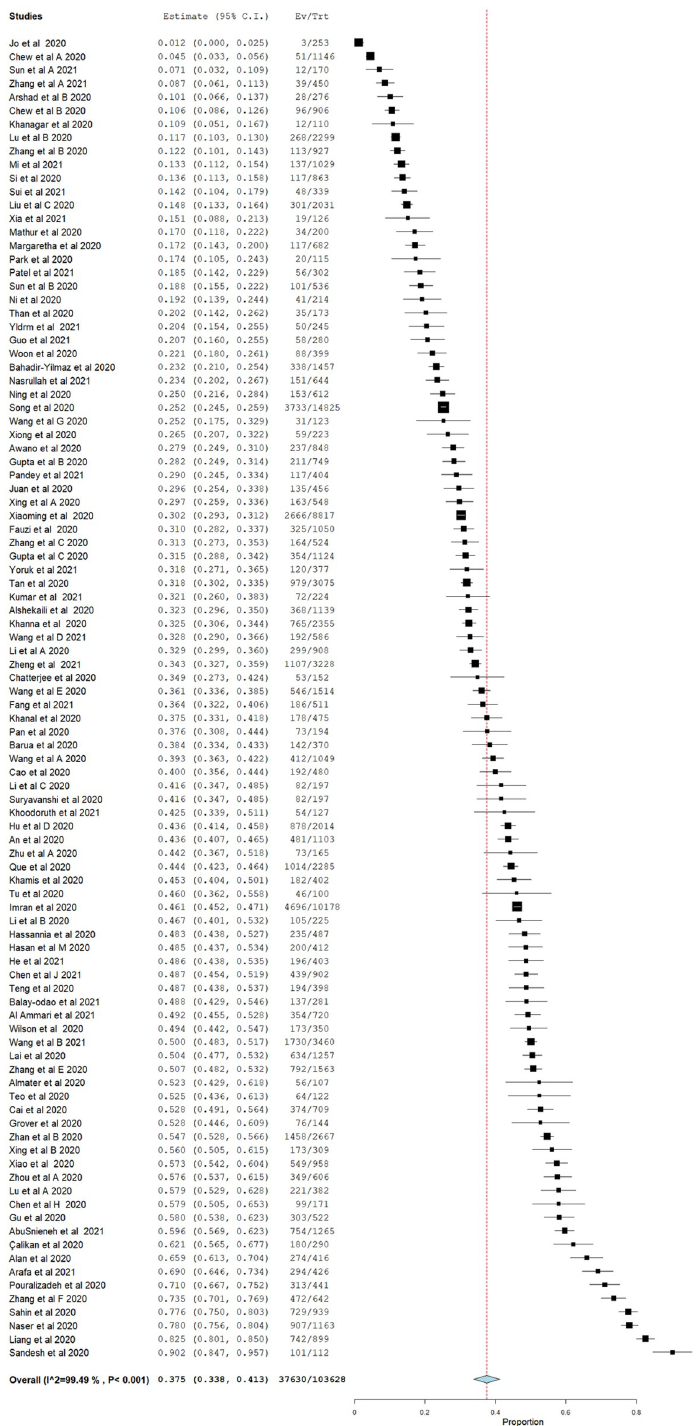
Fig 2. Forest plot of overall pooled prevalence of